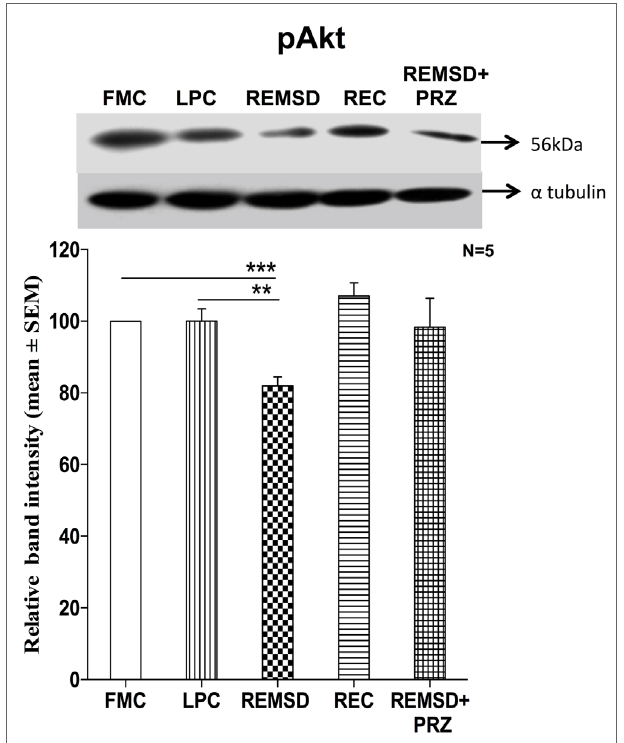
FigUre 7 | pakt expression in the brain homogenate of rats maintained under various conditions . Upper panel shows a representative Western blot of pAkt. Histogram in the lower panel shows percent changes in the mean ( ± SEM) band densities of the blots as compared to FMC taken as 100% in five sets of experiments. Abbreviations are as in the text. Significance levels are between the treatments of connecting horizontal bars; *** p < 0.001 and # p < 0.05, * as compared to FMC and # as compared to